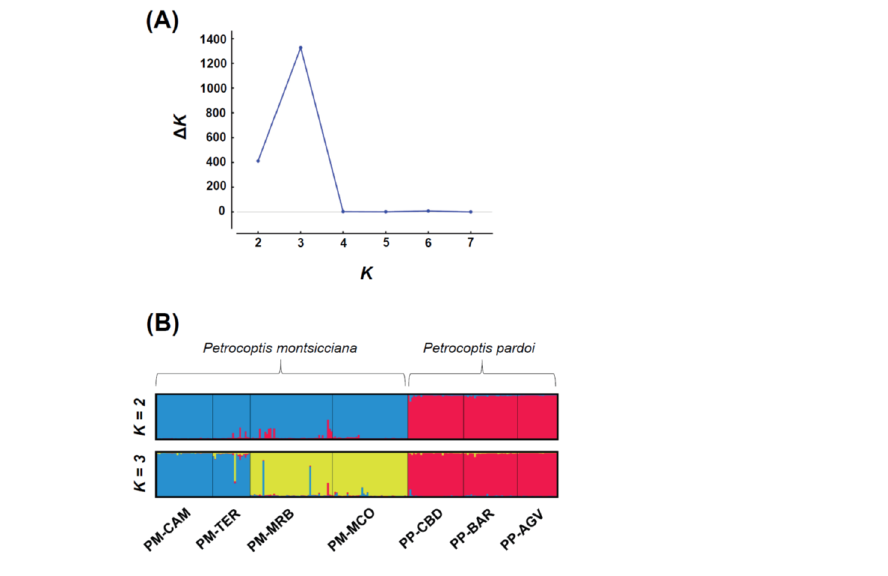
Figure 2. Results of Structure v.2.3.4 analysis for the pair Petrocoptis montsicciana / P. pardoi . ( A ) graphical representation of Δ K values obtained from Structure Harvester v.0.6.94; ( B ) assignation of individuals to genetic clusters at K = 2 and K = 3 after running Clumpp v.1.1.2 and Distruct